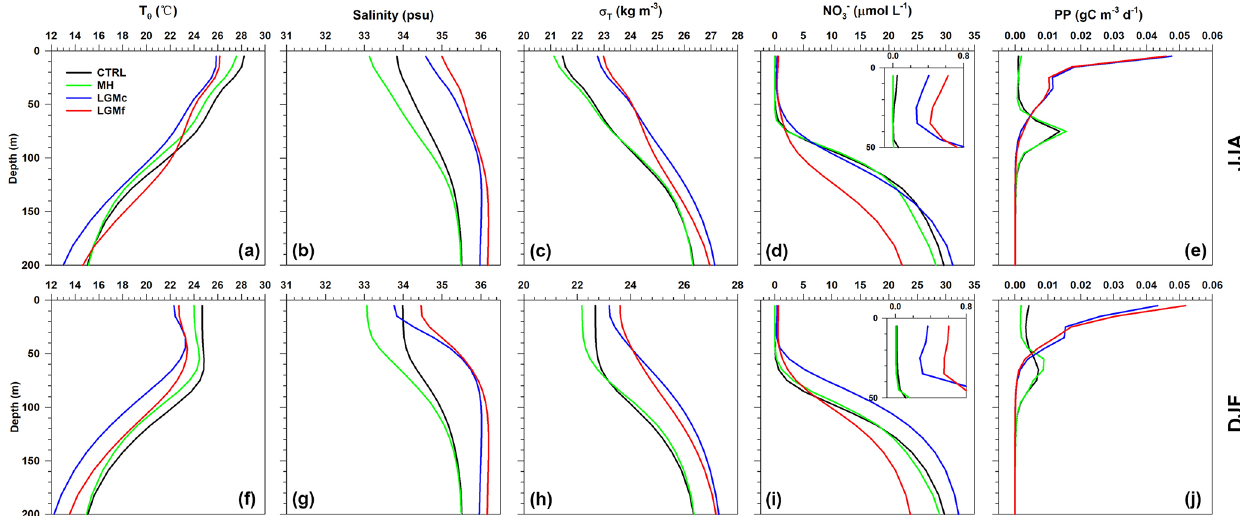
Figure 5. Simulated ocean profiles between 0 and 200m of water depth in four experiments run with IPSL-CM5A-LR. (a–e) Results for summer (June–July–August, JJA). (f–j) Results for winter (December–January–February, DJF). Data have been extracted from the grids located in the northeastern part of the BoB closed to the MD77-176 core site (rectangle 3 in Fig. 3e). The parameters shown here are potential temperature ( T θ ), salinity, potential density (sigma- t , σ T ), nitrate concentration of seawater representing seawater nutrient content (NO − ), and total primary productivity (PP). The nutricline, halocline, and pycnocline are the depths with the largest vertical gradients of 3 nutrient content, potential density, and salinity under the upper seawater